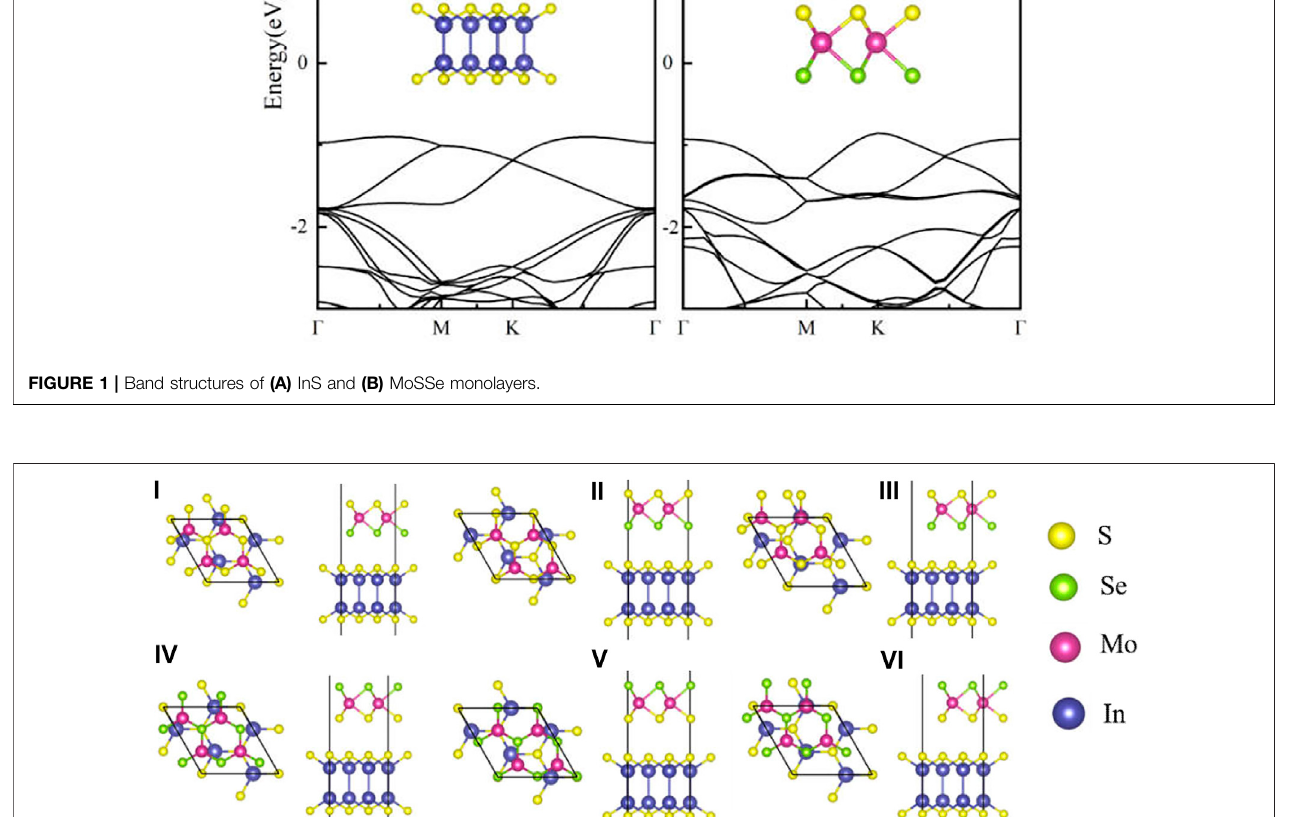
Figure 4B . The red dotted line and the blue dotted line represent the vacuum level (E vac ) and the Fermi level (E f ), respectively, and Φ is the work function which can be obtained by the difference between Evac and E f , and its value is 5.51 eV. The charge density difference is in the lower left corner of Figure 4B , − ρ − ρ ρ which is given by Δ ρ (cid:2) ρ M MoSSe InS , where MoSSe / InS , oSSe/InS ρ ρ MoSSe and InS are the total electron densities of the MoSSe/InS vdWH, MoSSe monolayer and InS monolayer, respectively. The